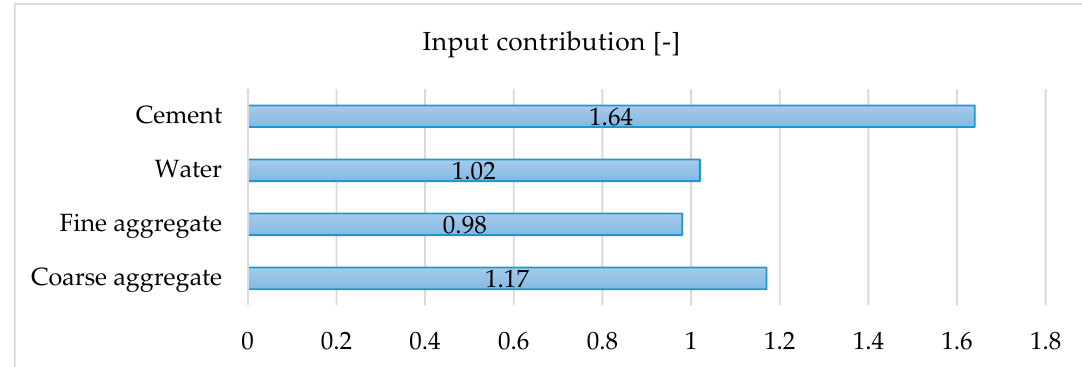
Figure 4. Input contribution.